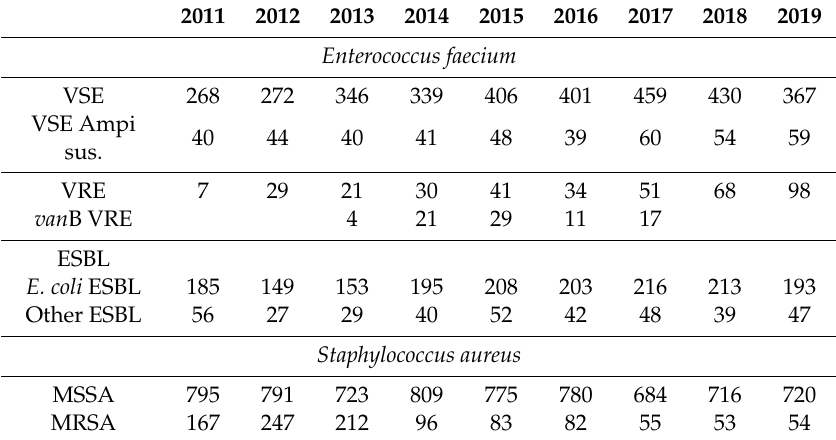
Table 2. Number of patients per year on wards other than ERWIN colonized with vancomycin- susceptible Enterococcus faecium (VSE), vancomycin resistant E. faecium (VRE), Gram-negative bacteria producing extended spectrum beta-lactamase (ESBL), methicillin resistant S. aureus (MRSA), and methicillin-susceptible S. aureus (MSSA). Systematic analysis of genotype mediating vancomycin resistance of VRE was performed from 2013–2016. Ampi sus.: